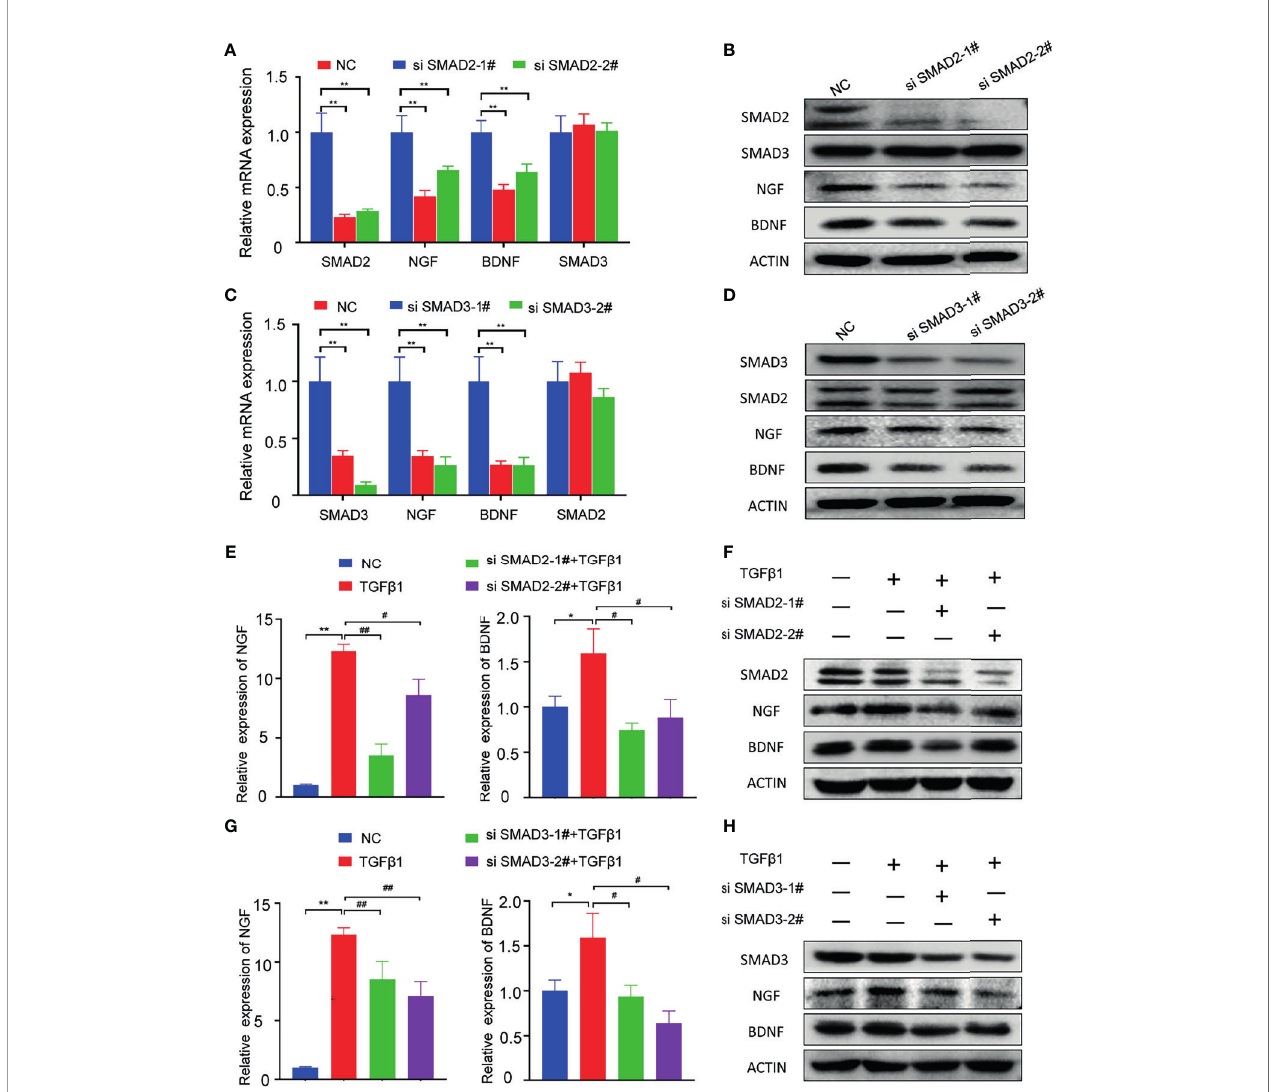
FIGURE 4 | Knockdown of SMAD2 or SMAD3 can inhibit the expression of NGF and BDNF. (A, B) qPCR and Western blotting analysis of the expression of SMAD2, SMAD3, NGF, BDNF in PANC-1 cell line after treated with SMAD2-speci fi c siRNAs; (C, D) qPCR and Western blotting analysis of the expression of SMAD3, SMAD2, NGF, BDNF in PANC-1 cell line after treated with SMAD3-speci fi c siRNAs; (E) qPCR analysis of the expression of NGF, BDNF in PANC-1 cell line after treated with TGF b -1 and SMAD2-speci fi c siRNAs; (F) Western blotting analysis of the expression of SMAD2, NGF, BDNF in PANC-1 cell line after treated with TGF b -1 and SMAD2-speci fi c siRNAs; (G) qPCR analysis of the expression of NGF, BDNF in PANC-1 cell line after treated with TGF b -1 and SMAD3-speci fi c siRNAs; (H) Western blotting analysis of the expression of SMAD3, NGF, BDNF in PANC-1 cell line after treated with TGF b -1 and SMAD3-speci fi c siRNAs. * p < 0.05, ** p < 0.01; # p < 0.05, ## p <